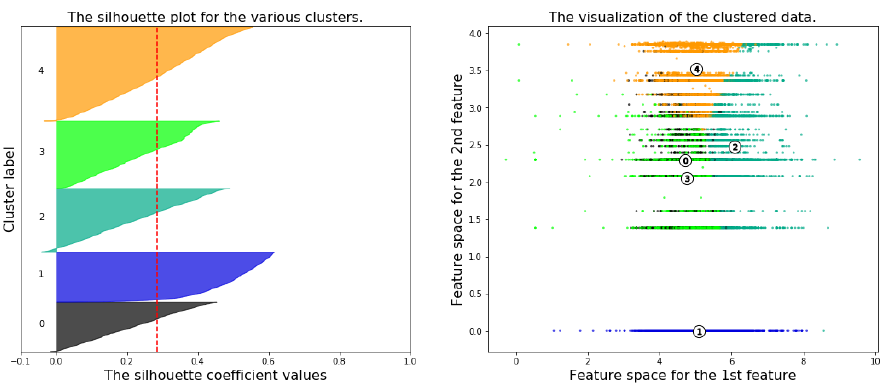
Figure 16. Silhouette analysis where the number of clusters is 5.